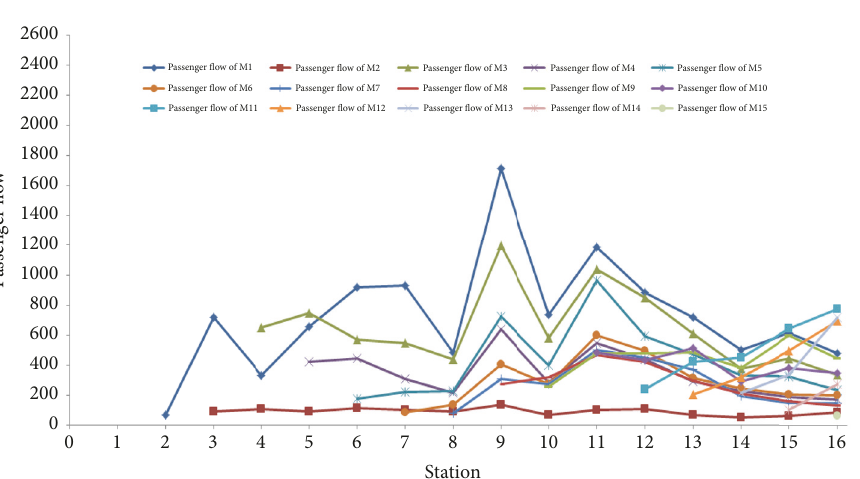
Figure 5: The daily passenger flow of line 4, phase 1 of Chengdu Metro (Source: The ACC office of Chengdu Metro).